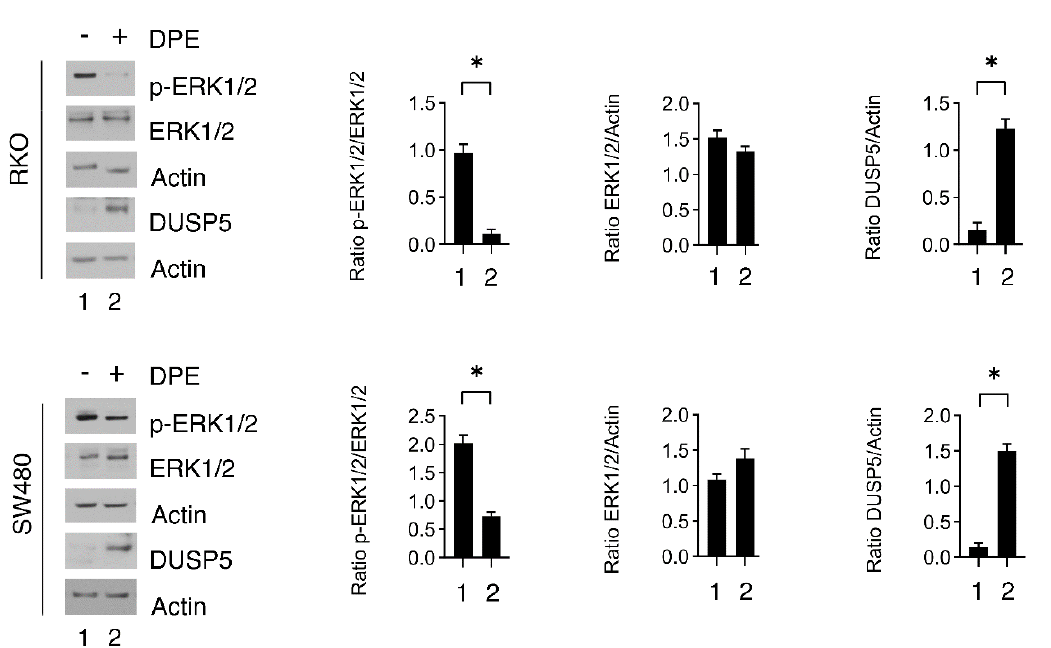
Figure 3. DPE upregulated DUSP5 and induces p-ERK dephosphorylation. RKO and SW480 were treated with DPE (50 µ M) or left untreated as controls. After 24 h, the expression levels of p-ERK1/2, ERK1/2, and DUSP5 were evaluated via Western blot analysis. β -Actin was used as the loading control. The histograms represent the means plus S.D. from the densitometric analysis of the ratio between the protein and the appropriate control. Note: * p < 0.05.